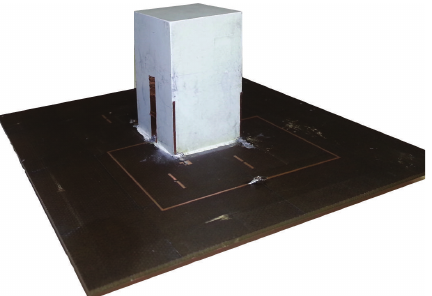
Figure 12: Manufactured prototype DRA with 𝑎 = 32mm, 𝑏 = 29.5 mm, 𝑑 = 48.85 mm, 𝜀 = 1.5 mm, 𝑀 21 mm, 𝑊 2 = 0.6 mm, 𝐿 = 130 mm, 𝑃 𝑉 rad